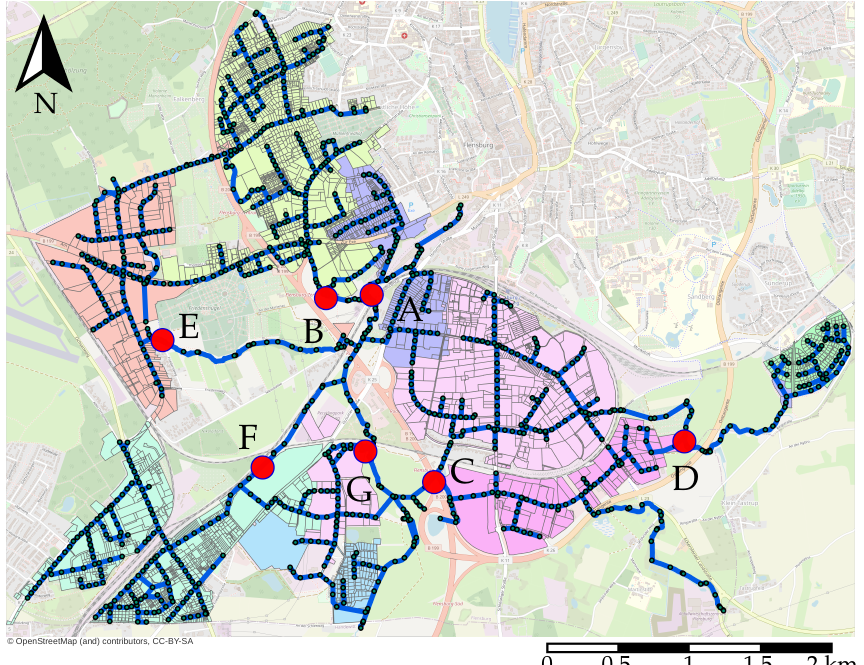
Figure 3. Overview of the stormwater network of Flensburg modelled with a pipe diameter threshold of 30 cm. Nodes of the model are highlighted with green dots, while the links are colored in blue. The red circles correspond to the points at which level sensors are considered later for system